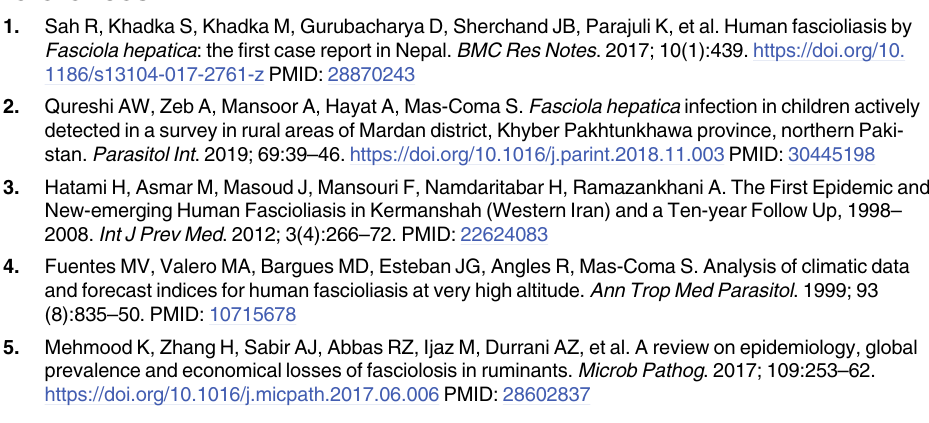
S5 Table. Adjusted Multivariate Logistic regression analysis stratified by higher or lower altitudes above the sea level associated with amount of livestock feces around different radiuses around the